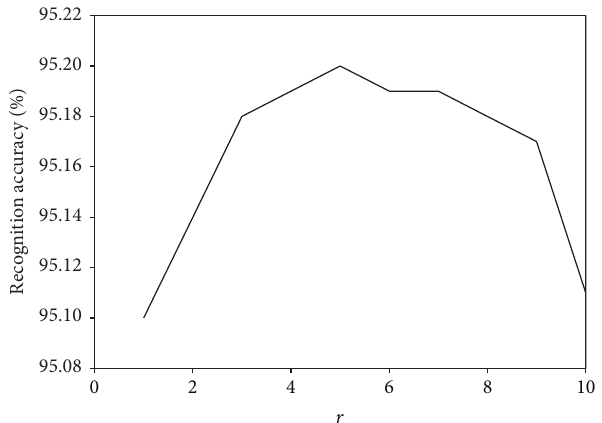
Figure 14: Recognition accuracy of MDGPP versus varying param- eter 𝑟 on the CMU PIE database.